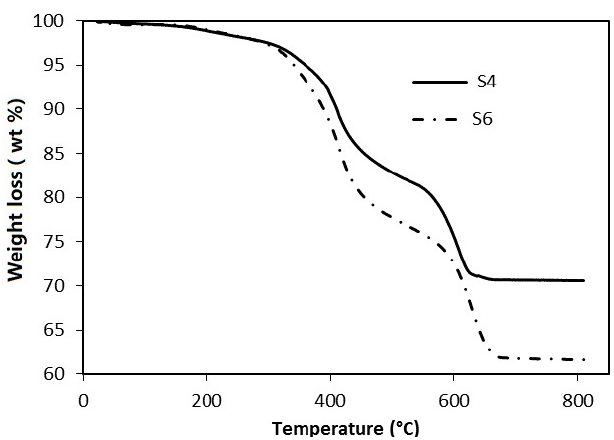
Figure 4. Comparison of the curves describing the normalized weight losses of the S4 and S6 samples.